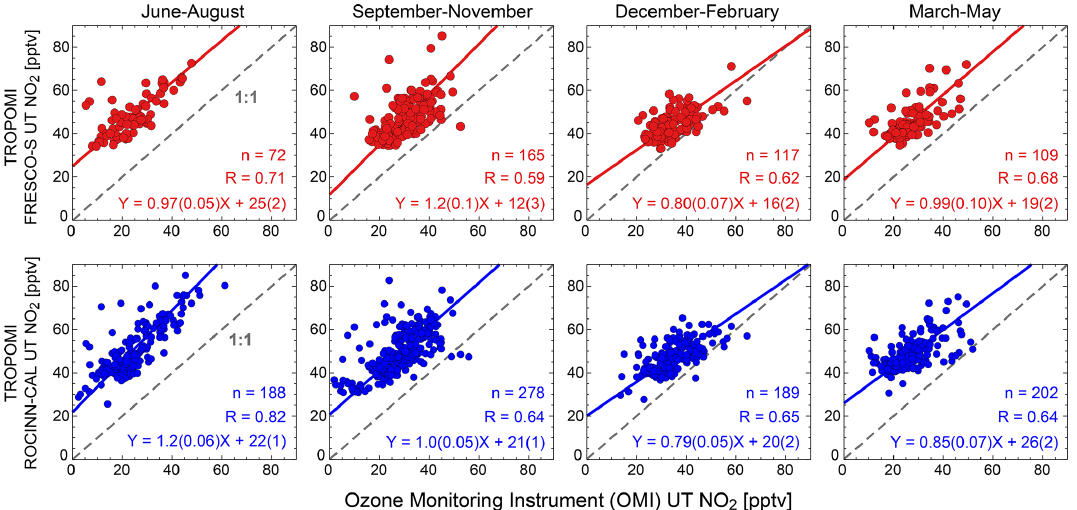
Figure 8. Comparison of TROPOMI and OMI cloud-sliced UT NO 2 . Points are seasonal means in June 2019 to May 2020 for TROPOMI and January 2005 to December 2007 for OMI gridded to the same 5 ◦ × 8 ◦ (latitude × longitude) grid for FRESCO-S vs. OMI (upper panel, red) and ROCINN-CAL vs. OMI (lower panel, blue). Values give the number of points, Pearson’s correlation coefficients ( R ), RMA regression coefficients, and, in parentheses, bootstrap resampling slope and intercept